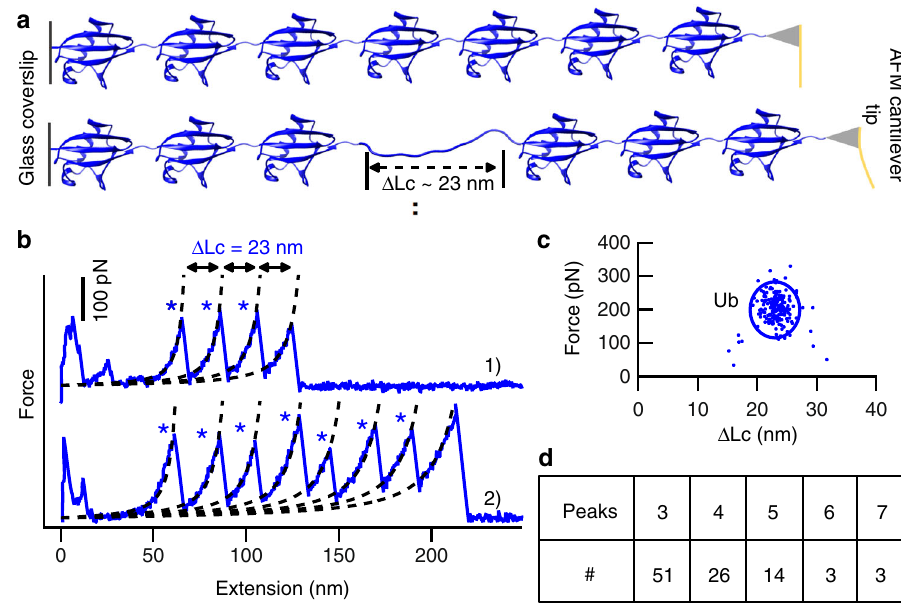
Fig. 2 The characterization of OaAEP1-built polyprotein by AFM-based SMFS. a The schematic displays the unfolding of ubiquitin polyprotein by single- molecule AFM, which leads to an unfolding peak with Δ Lc of ~23 nm. b Two representative force-extension curves of (Ub) n are shown with expected Δ Lc and different peaks indicated by blue star, three peaks in curve 1, and seven peaks in curve 2. c The scatter plot of the (Ub) n unfolding experiment showed the relationship between protein unfolding force (202 ± 44 pN, average ± s.d., n = 198) and Δ Lc (23 ± 2 nm, average ± s.d.). d The statistical analysis of the (Ub) n indicated the number of curves with speci fi c unfolding peaks. Most curves showed three (52%) and four (27%) unfolding peaks. Source data of Fig. 2c are provided as a Source Data fi